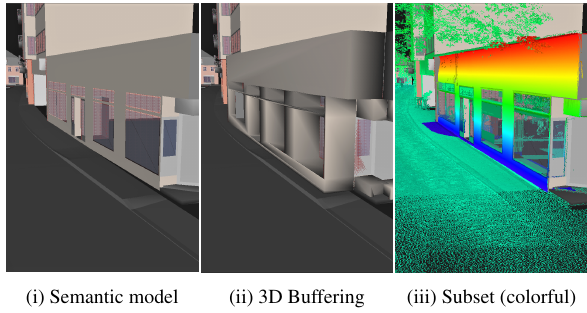
Figure 5. Identification of the point cloud subset (colorful) that presumably represents the wall surface of the semantic model.